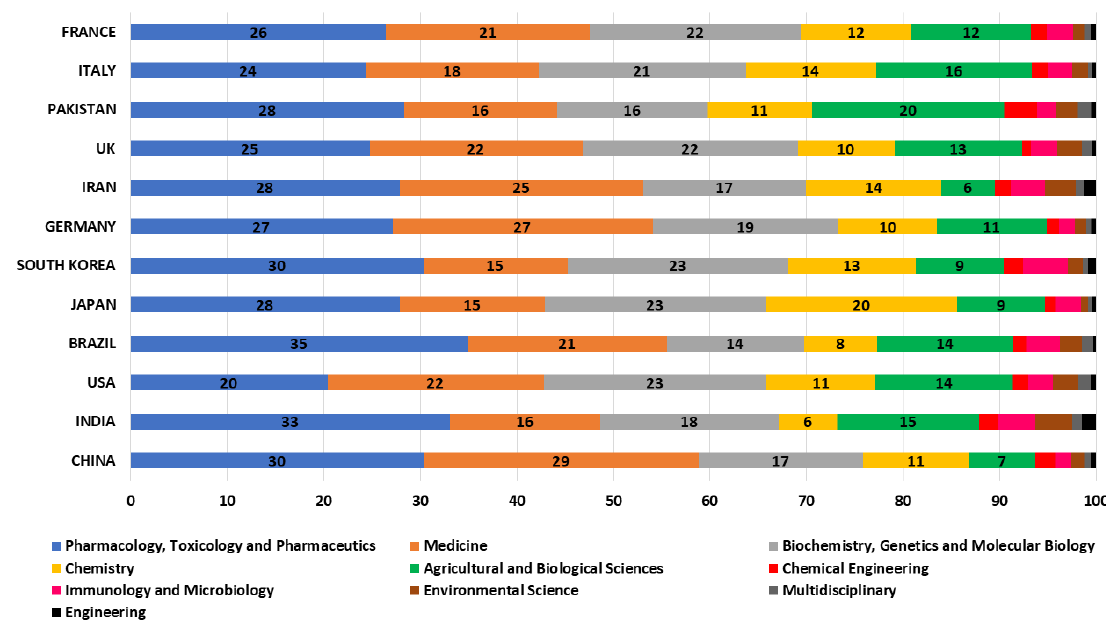
Figure 6. Distribution by scientific categories according to countries.